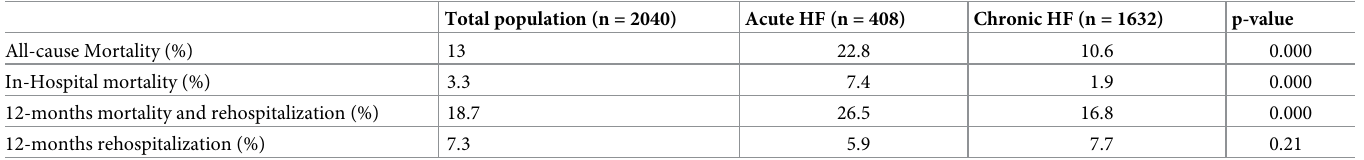
Table 2. Causes of death and rehospitalization of all study